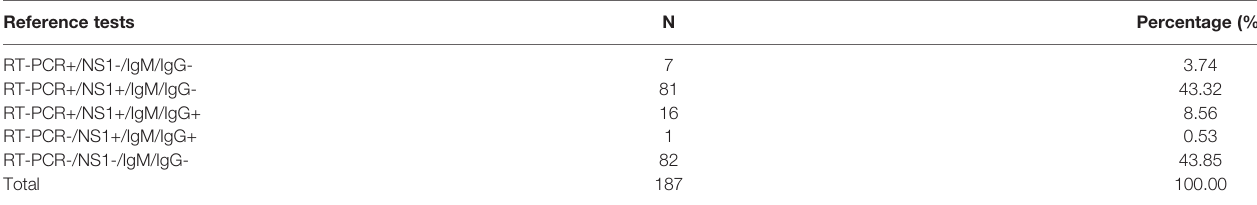
TABLE 4 | Detection results of RT-PCR, Dengue NS1 antigen ELISA, and Dengue speci fi c IgM/IgG capture ELISA when applied to 187 serum samples. Reference tests